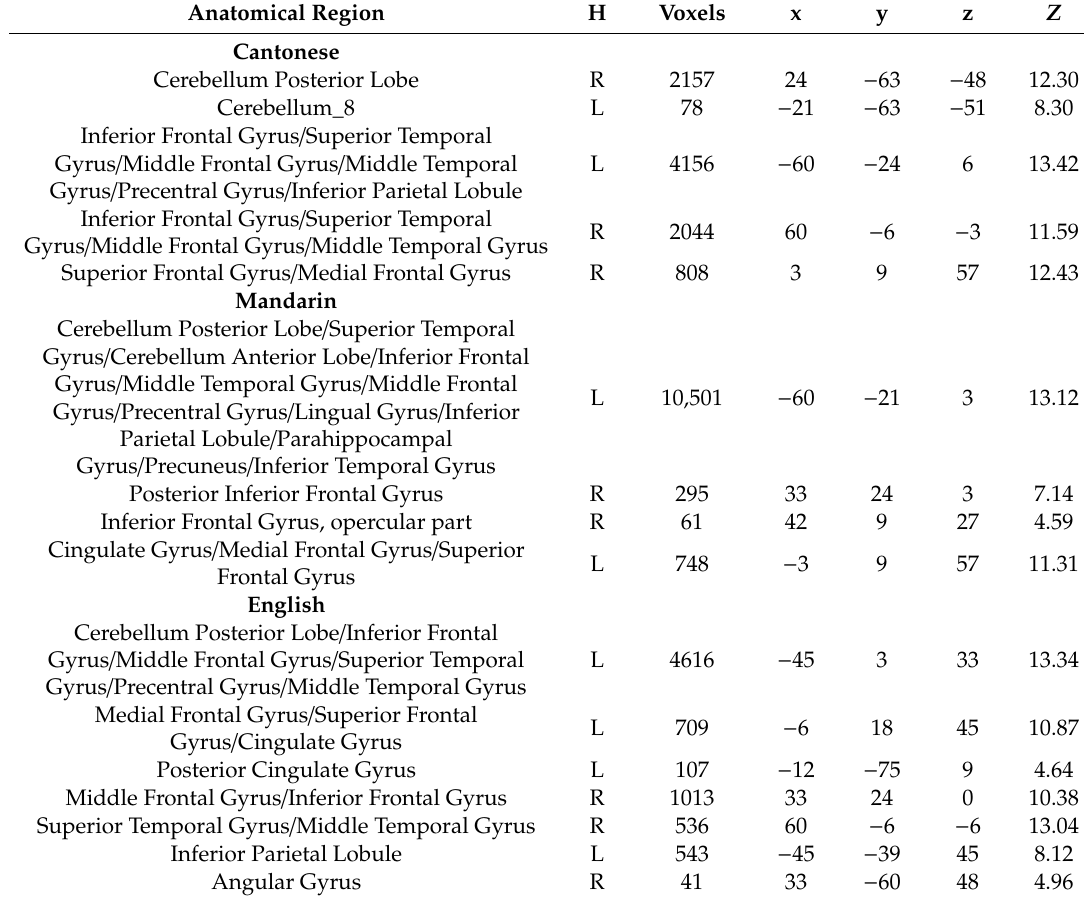
Table 5. Brain activity of Cantonese, Mandarin and English for the contrast of rhyming minus control in auditory modality.